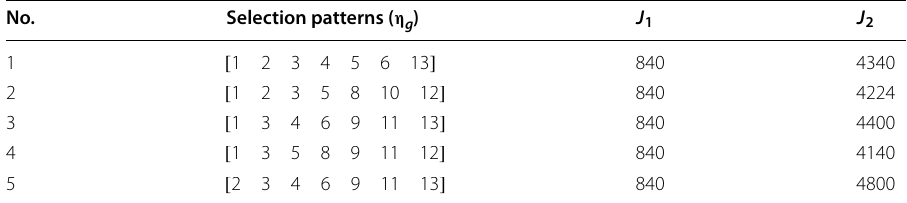
Table 3 Five information selection patterns from 1716 patterns that result in min ( J 1 ) and min ( J 2 )